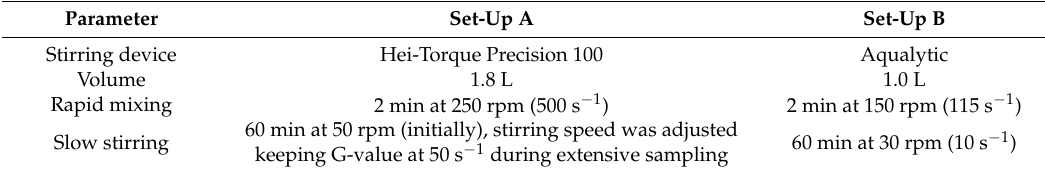
Slow stirring keeping G-value at 50 s − 1 during extensive sampling